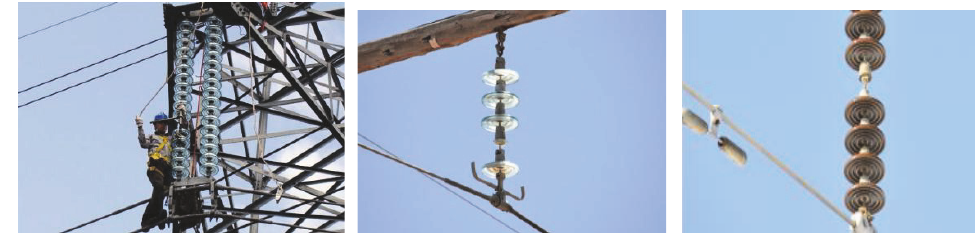
Figure 1: Electrical safe inspection captured by UAV Imaging